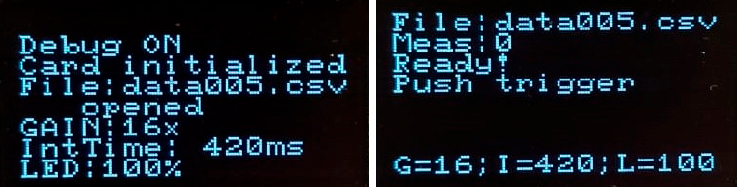
Figure 2. Image of the device’s integrated OLED screen showing initialization data ( left ) and ready to perform data capture ( right ).